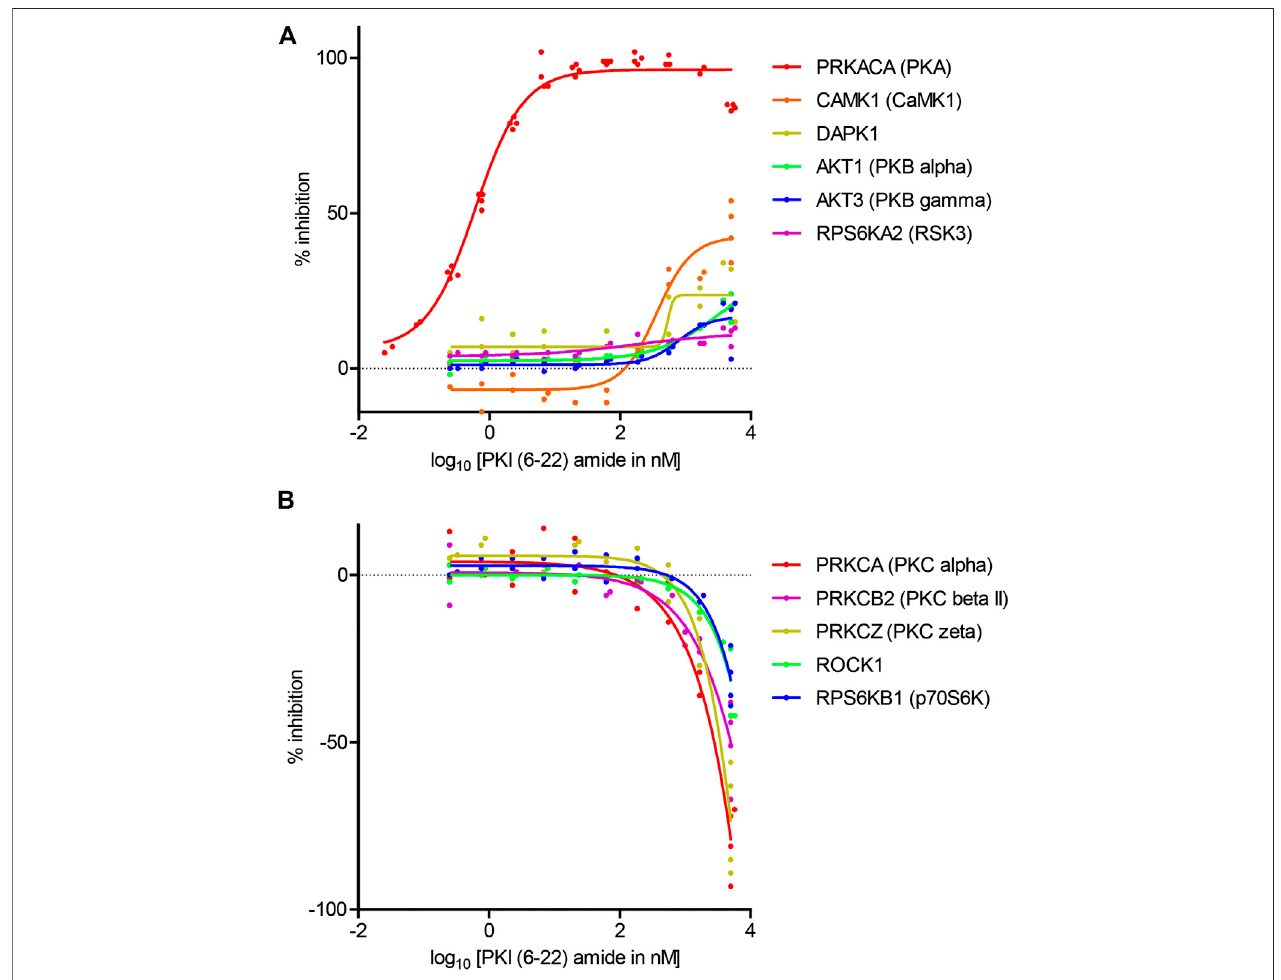
FIGURE3| Dose-responsecurvesoftheeffectsofPKI(6 – 22)amideonkinaseactivity. (A) Dose-responsecurveofPKI(6 – 22)amideoninhibitedkinases. (B) Dose response curve of PKI (6 – 22) amide on facilitated kinases. The 5 µM PKI(6 – 22) amide replicates for the relevant enzymes from Figure 2 were also plotted with the 5 µM PKI(6 – 22) amide data here to show variabilityofdata. N (cid:1) 2 – 4for each PKI concentration and each enzyme. The graph shows individual replicates (staggered dots) and fi tted curves for each enzyme.